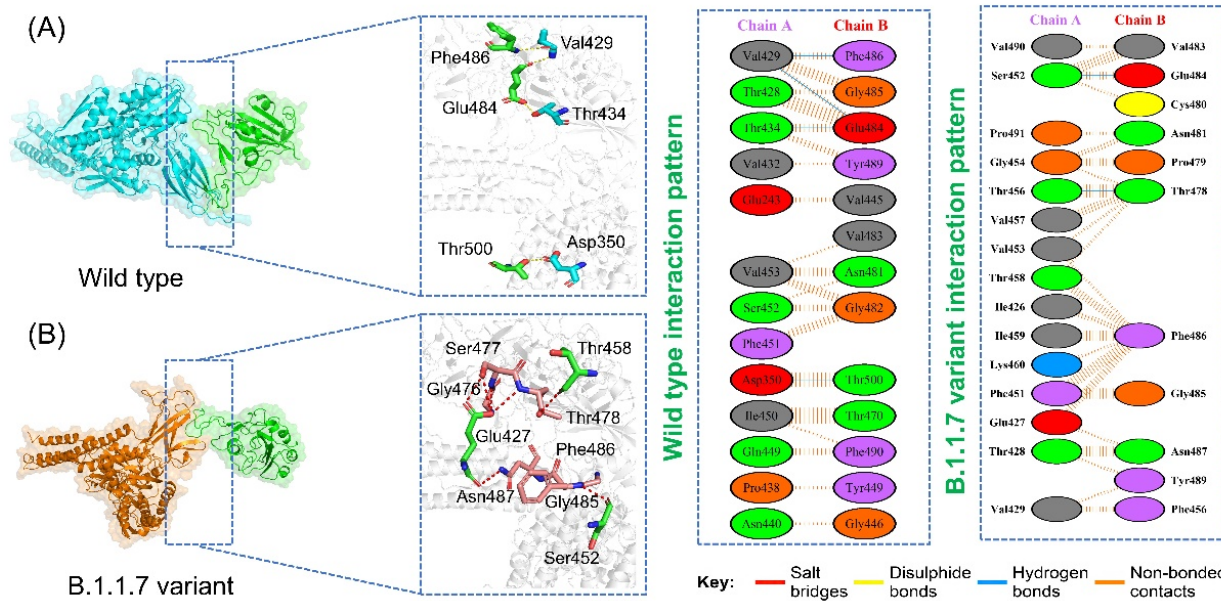
Figure 2. Binding modes of GRP78 and spike RBD of the wild-type and B.1.1.7 variant. ( A ) shows the interaction of GRP78 and RBD of the wild-type, while ( B ) shows the interaction of GRP78 with B.1.1.7-RBD. The right panels show the 2D interaction patterns of the wild-type and B.1.1.7.